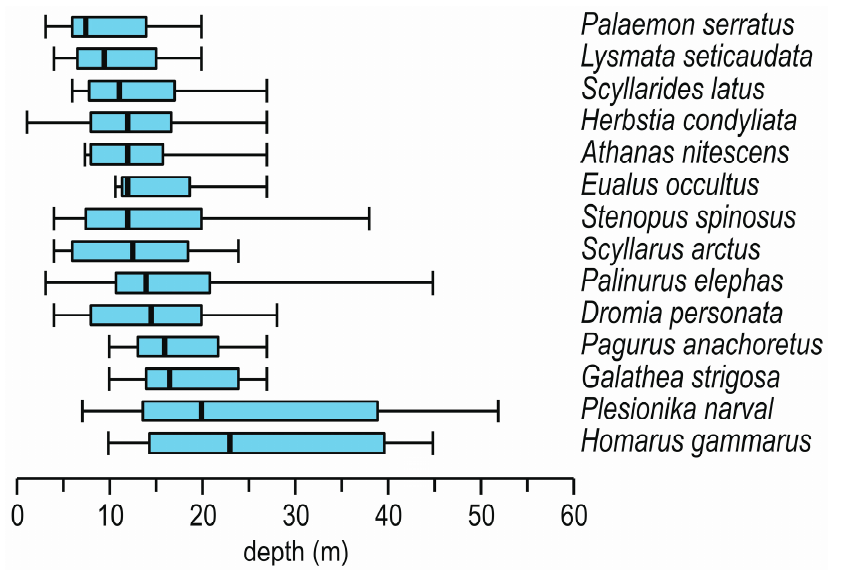
Figure 5. Depth preference of selected cave decapod species (depth is that of the seafloor at the entrance of the cavity). Boxes depict the 25–75 percent quartiles; the thick vertical line inside the box indicates the median; the whiskers represent minimal and maximal values.